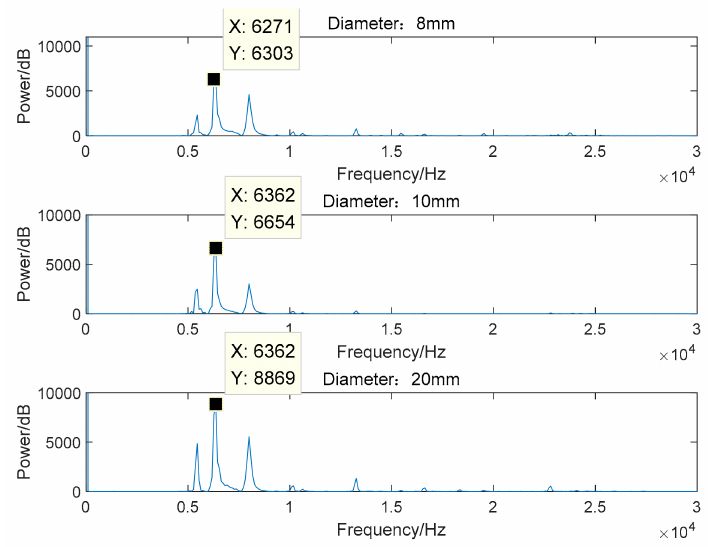
Figure 12. The power spectrum curves of steel balls with different